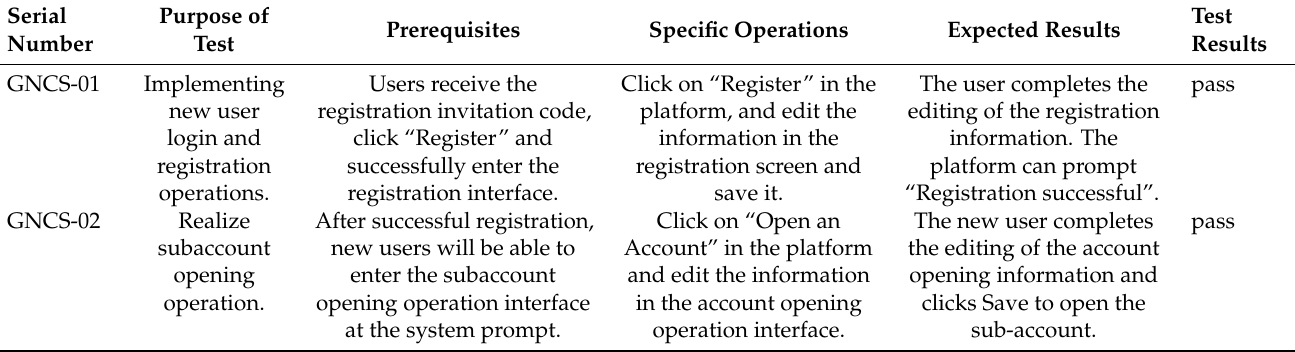
Table 2. Login registration and account opening function test case list.